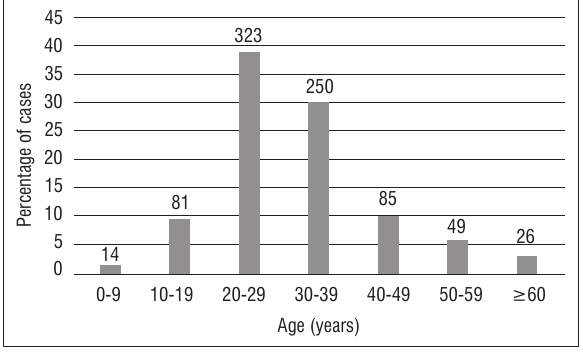
Percentage age distribution of victims of blunt force trauma homicide from 2010 to 2014.